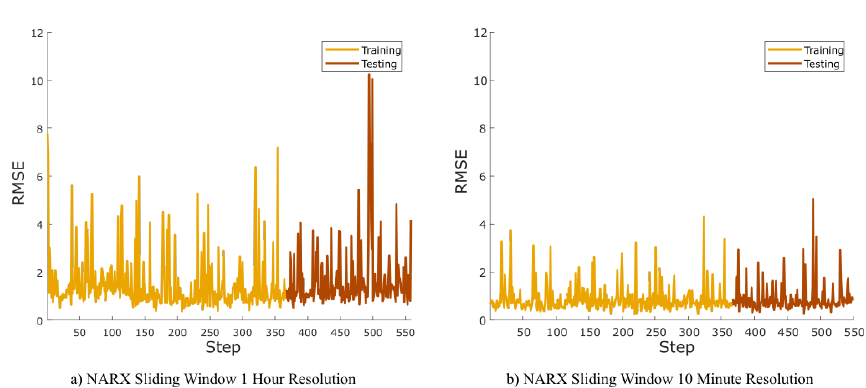
Figure 6. Comparison between 1 h and 10 min time average SCADA data for the NARX model with 12 months of training data.